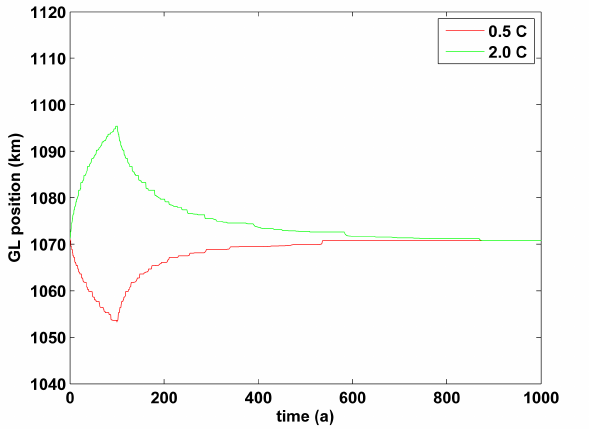
Fig. 4. Grounding-line positions as functions of time following per- turbations in basal slipperiness ( C ). The grounding-line positions shown are for y = 0, i.e. where the grounding lines cross the me- dial line. Both runs started from the steady-state solution shown in Fig. 2. The value of C was changed by a factor of 1 / 2 and 2 from the value listed in Table 1. The perturbations were applied for 100yr, and the model then run towards steady state. As the figure shows both models converged back to the original steady state, showing that the initial steady state is stable with respect to such perturba- tions in C .